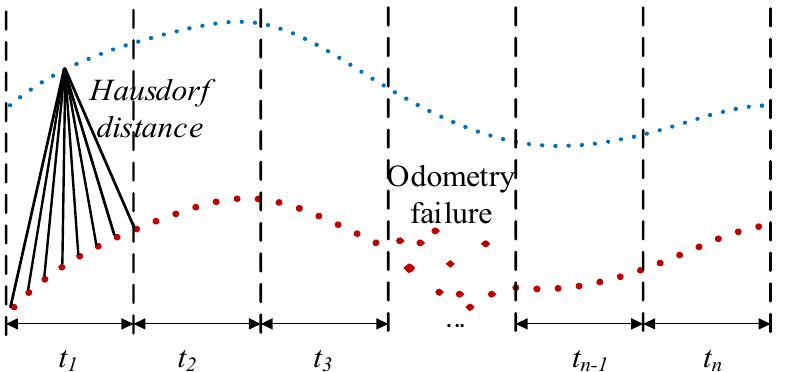
Figure 4. Trajectory similarity selects initial calibration trajectory segment. The red dots represent the lidar odometry localization data; the blue dots represent the IMU odometer localization data.